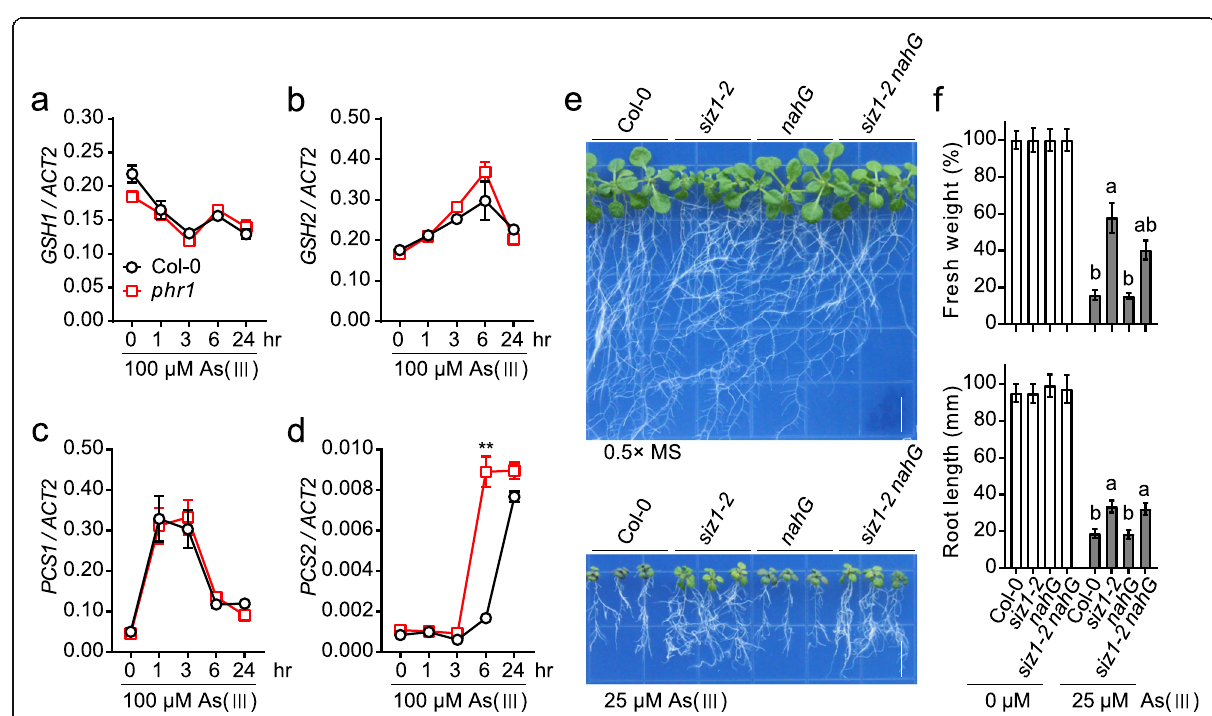
Fig. 4 The effect of phr1 mutation and SA accumulation on arsenite resistance of siz1 mutants. a - d The transcript levels of GSH1 ( a ), GSH2 ( b ), PCS1 ( c ), and PCS2 ( d ) determined by qRT-PCR analysis in Col-0 and phr1 seedlings after 100 μ M As (III) treatment for the indicated time. The ACT2 was used as an internal control. Values are means ± SD ( n = 3). ** P < 0.01, Student ’ s t test. e Arsenite resistance assay of Col-0, siz1 – 2 , nahG , and siz1 – 2 nahG . The seedlings grown on 0.5× MS medium were transferred to the medium containing 25 μ M As (III) for 12 days. Bar, 1 cm. f The fresh weight and root length measured from the seedlings shown in ( e ). Values are means ± SD of three replicates, each replicate containing 9 plants per genotype. The letter a and b above columns indicate significant difference ( P < 0.05, Student ’ s t test) among the